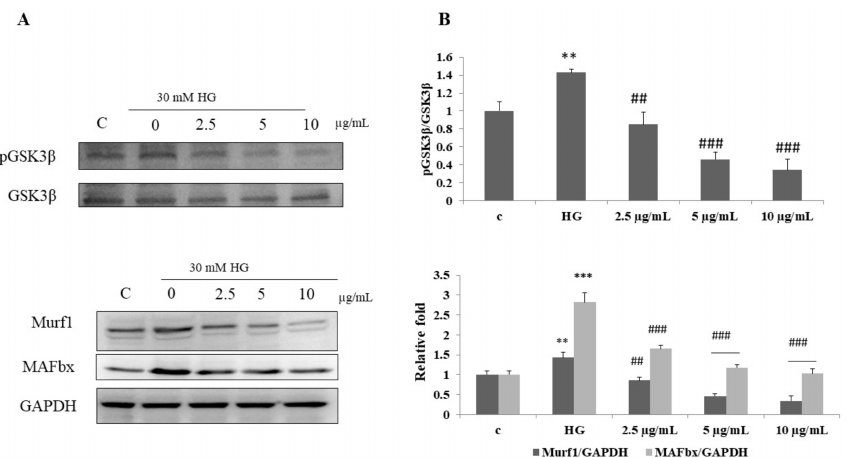
Figure 6. Effect of DI-10 on the protein involved in muscle atrophy. ( A ) DI-10 inhibits muscle atrophy under hyperglycemic conditions through modulating pGSK3 β , MAFbx and MuRF1. ( B ) Graph showing densitometric analysis. *** p < 0.001 and ** p < 0.01 compared to control group and ### p < 0.001 and ## p < 0.01 compared to the high